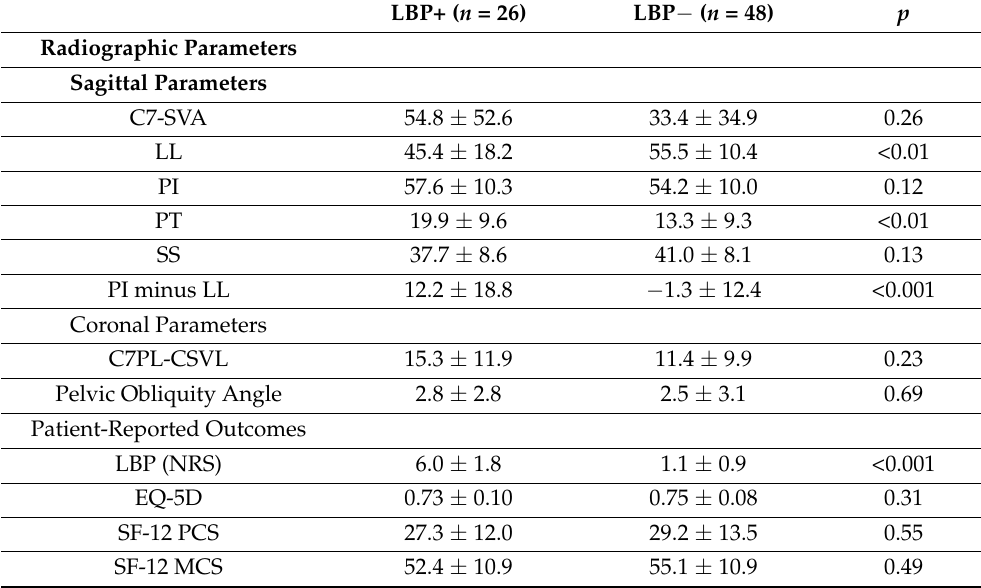
Table 2. Comparison of preoperative radiographic parameters and patient-reported outcomes between patients with and without preoperative lower back pain.